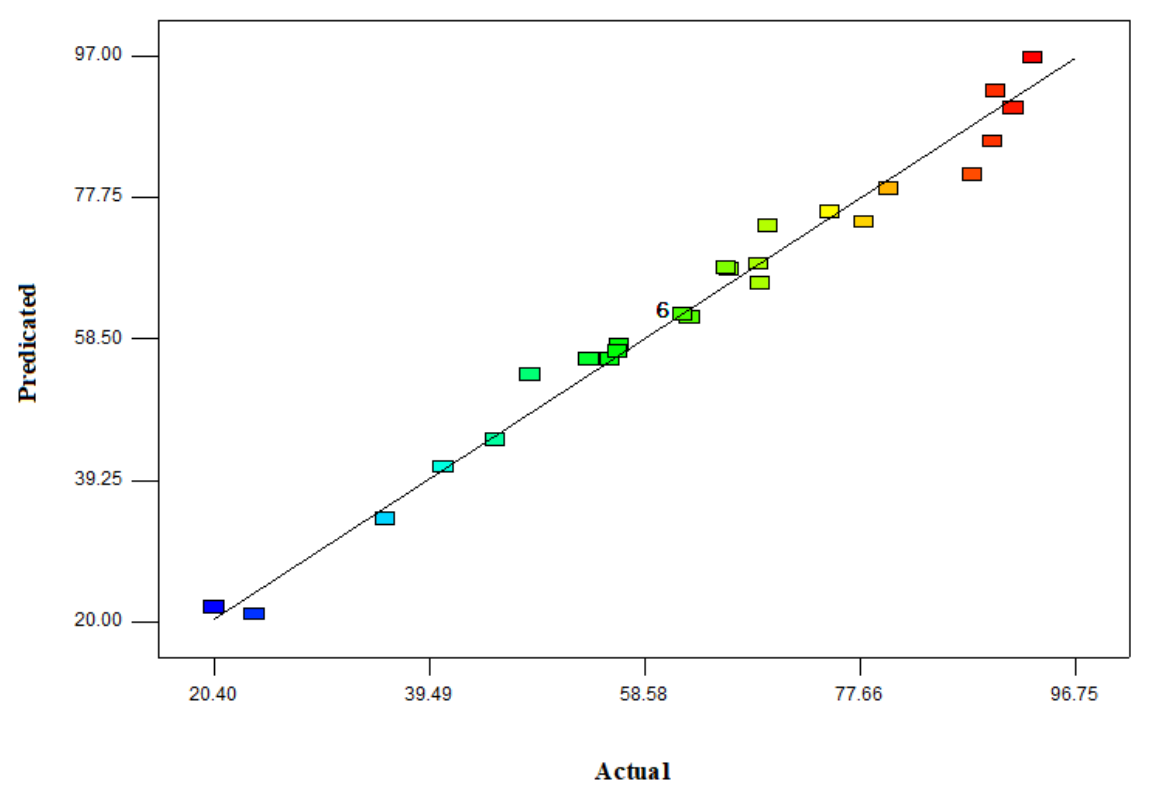
Figure 6. Actual and predicted perecentage of MB removal by Fe 3 O 4 /CA. The percentage contributions (PCs) of each independent variable for the perecentage dye removal were estimated using Equation (4) [38] by using the ANOVA results, with the results presented in Table 5. The solution pH (B) showed the highest influence on the perecentage dye removal as its contribution was 62.7%, followed by the adsorbent dose (C) at 11.3%, interaction (BC) at 8.2%, contact time (D) at 7.1%, interaction (AB) at 5.6%, and initial dye concontration (A) at 3.4%. The interaction terms (AD), (BD), and (C 2 ) had the lowest effects on the perecentage dye removal.